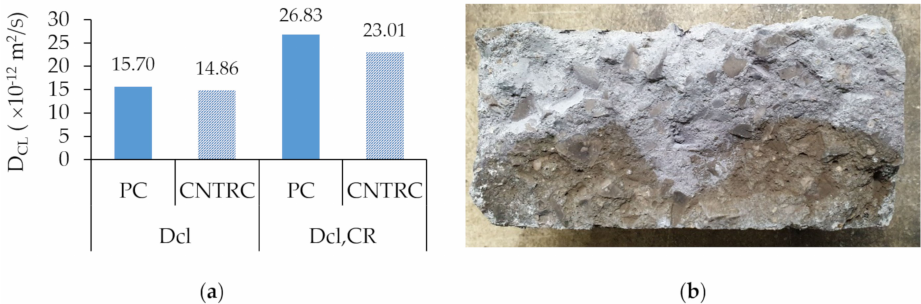
Figure 5. ( a ) Chloride coefficients in artificially cracked concrete. ( b ) Artificially cracked specimens after chloride